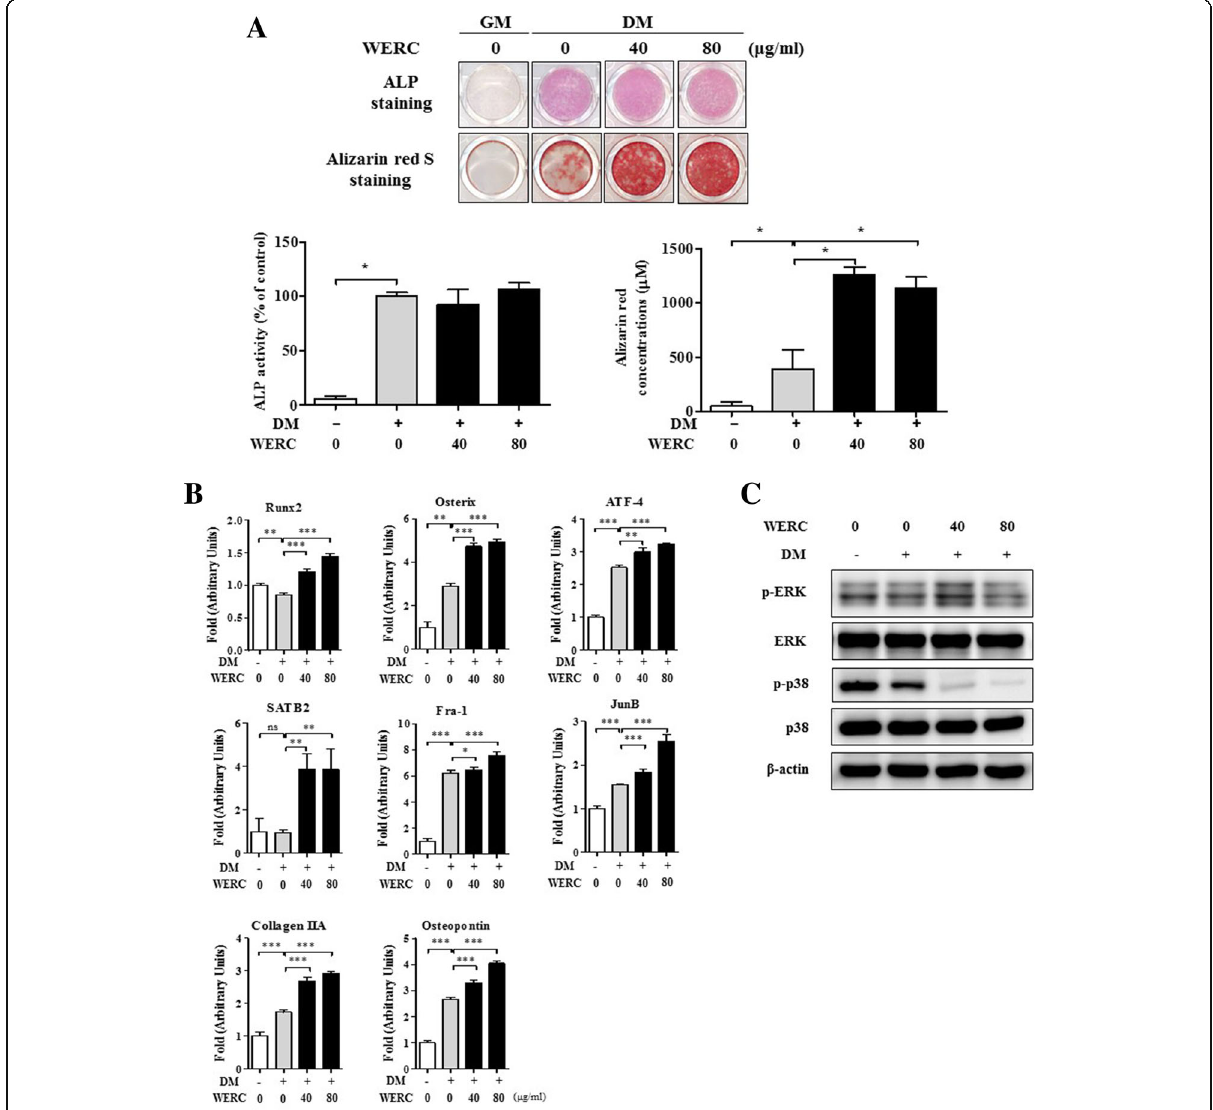
Fig. 3 WERC stimulates osteoblast mineralization by increasing osteoblast gene expression and ERK signaling. Osteoblasts isolated from mouse calvariae were cultured in growth medium (GM, α -MEM) or differentiation medium (DM; 50 μ g/mL ascorbic acid, and 10 mM β -glycerophosphate in α -MEM) in the presence of WERC (40 and 80 μ g/mL). ( a ) Osteoblasts were subjected to ALP staining on day 5 (upper panel) or alizarin red S staining on day 10 (lower panel) (40 × magnification). Quantification of ALP activity was determined using the ALP activity assay. Quantification of mineralization was determined by measuring the amount of alizarin red S dye extracted from stained cells. ( b ) mRNA levels of Runx2, osterix, ATF-4, SATB2, Fra-1, JunB, collagen IIA, and osteopontin were determined by qRT-PCR on day 10. ( c ) After culturing osteoblasts in DM and WERC to 10 days, total cell lysate (30 μ g) was extracted and subjected to western blot analysis with antibodies specific to ERK, p38, and β -actin. * p < 0.05, ** p < 0.01, *** p <